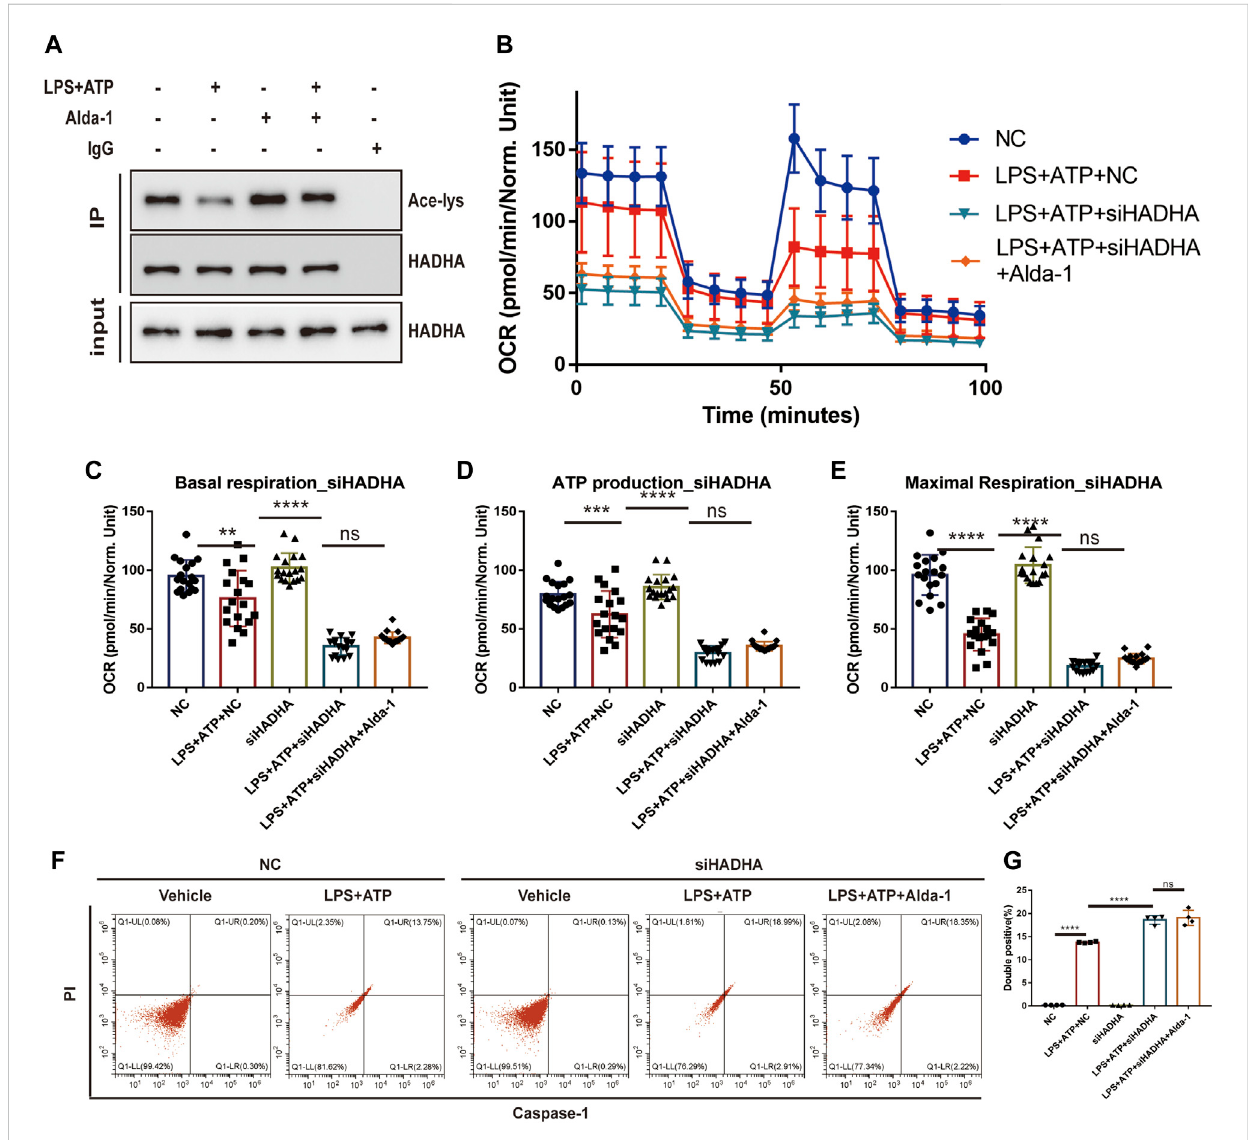
FIGURE 6 HADHA deacetylation is responsible for mitochondrial damage and cardiomyocytes pyroptosis, and ALDH2 suppresses HADHA deacetylation. (A) Representative immunoblots of HADHA acetylation levels in LPS plus ATP-stimulated or control H9C2 cells with or without pre-treated Alda-1, n = 3 per group. (B – E) MitochondrialrespirationmeasurementsofOCRin Hadha silencedornegativecontrolH9C2cellswithorwithoutLPSplusATPstimulation, quanti fi cationofbasal respiration, ATPproduction,andmaximalrespiration. (F,G) Representative fl owcytometry graphsshowingpositive-caspase- 1/PI double staining in Hadha silenced or negative control H9C2 cells with or without LPS plus ATP stimulation and quantitative analysis of the double positive, n = 4 per group. Mean ± SEM. **** p < 0.0001; *** p < 0.001; * p < 0.05; ns = not signi fi